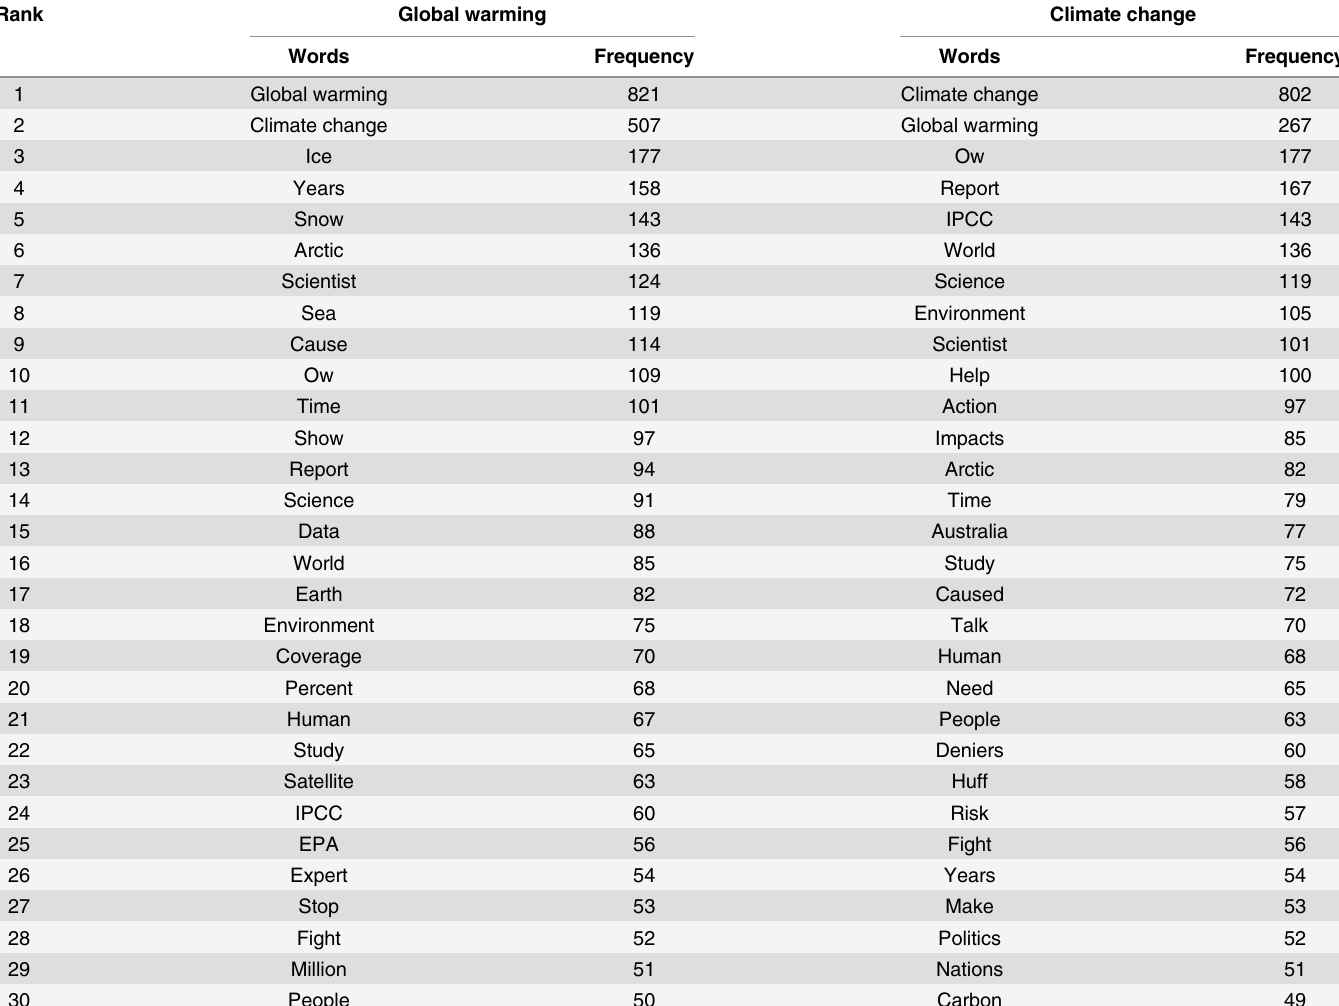
Table 1. Tweet Terms-frequency Dictionary for Global Warming and Climate